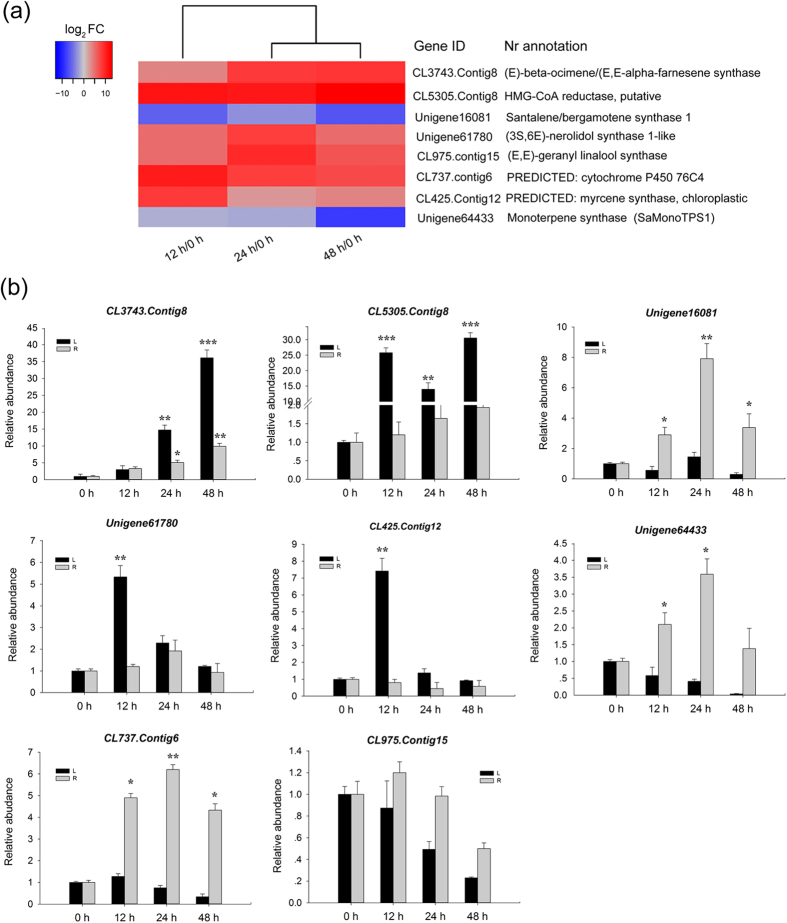
Differentially expressed genes involved in terpenoid biosynthesis in response to cold stress.(a) Heat map of changes of transcript abundance for eight genes. (b) qRT-PCR determination of transcript levels of these genes in leaves and roots following cold treatment (4 °C). Three measurements were averaged from the results of three replicated experiments and statistically treated using a t-test. *P ≤ 0.05 > 0.005; **P ≤ 0.005 < 0.001; ***P < 0.001. L, leaves. R, roots.